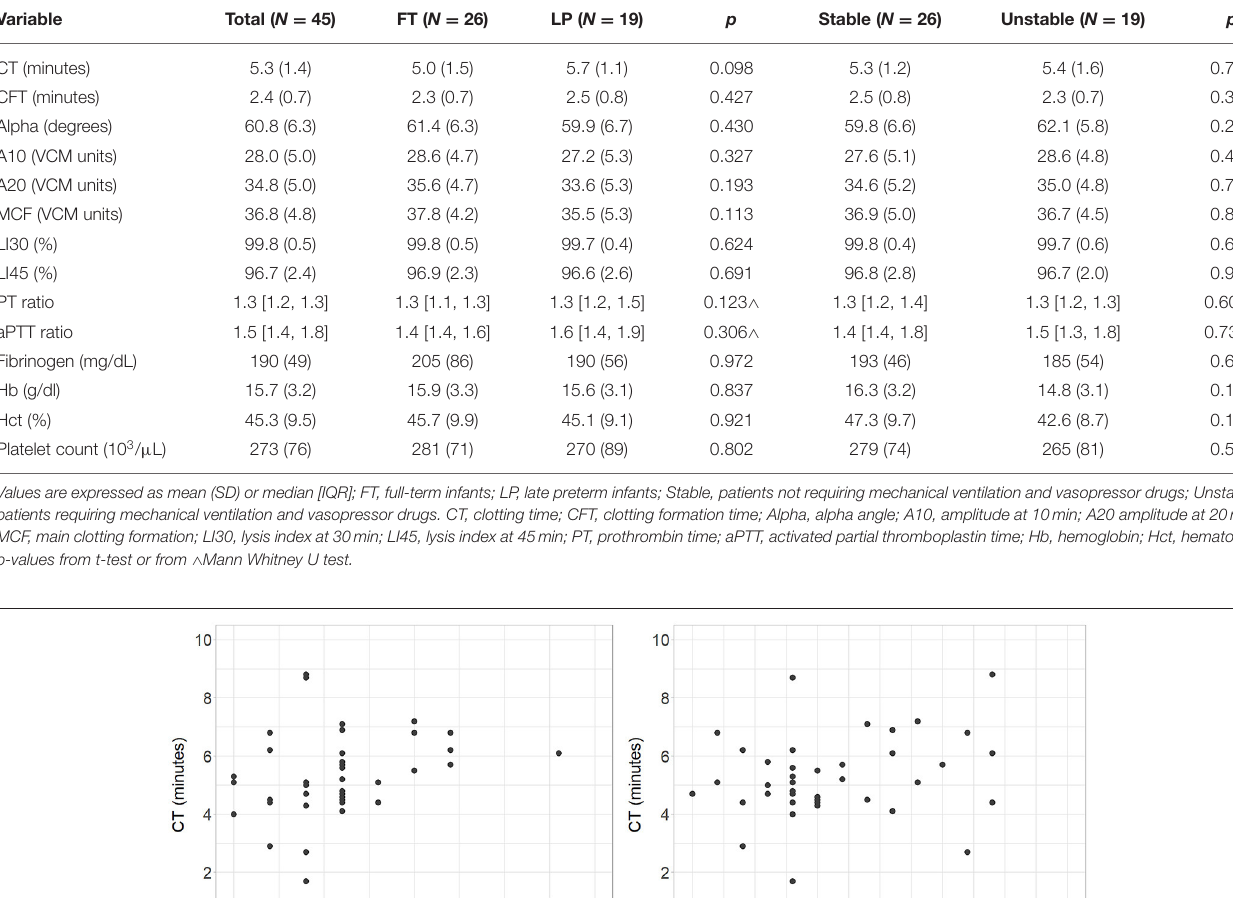
variables were described as mean (standard deviation) or